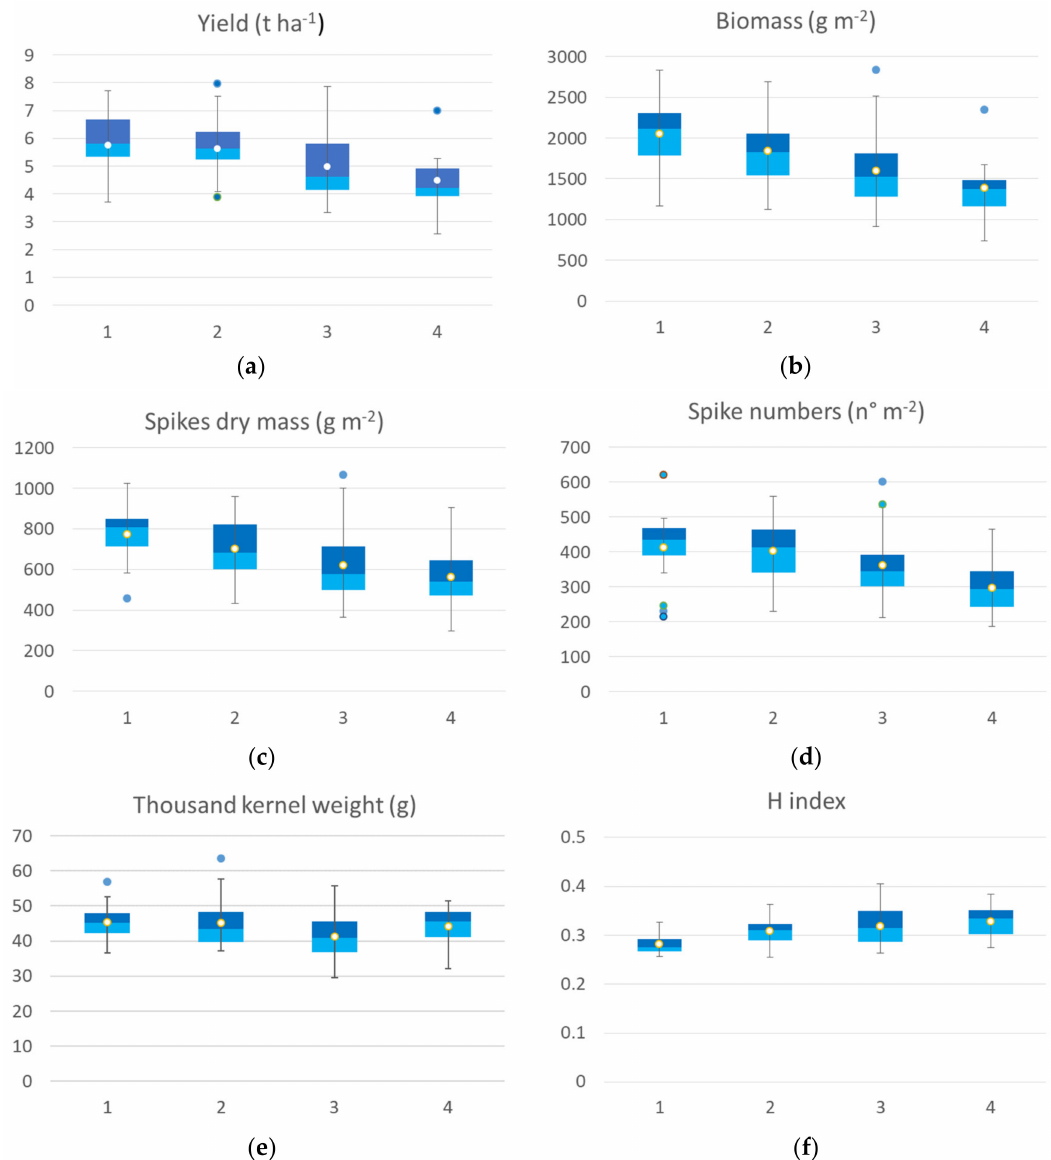
Figure 5. Box plot of agronomic traits collected at harvest: yield ( a ), biomass ( b ), spike weight ( c ), spike number ( d ), thousand-kernel weight ( e ) and harvest index ( f ) of the seven durum wheat cultivars grouped according to the 4 identified VI clusters at seedling. All the components showed a significant difference among clusters, and thousand kernel weight showed no significant differences among clusters (Kruskal–Wallis